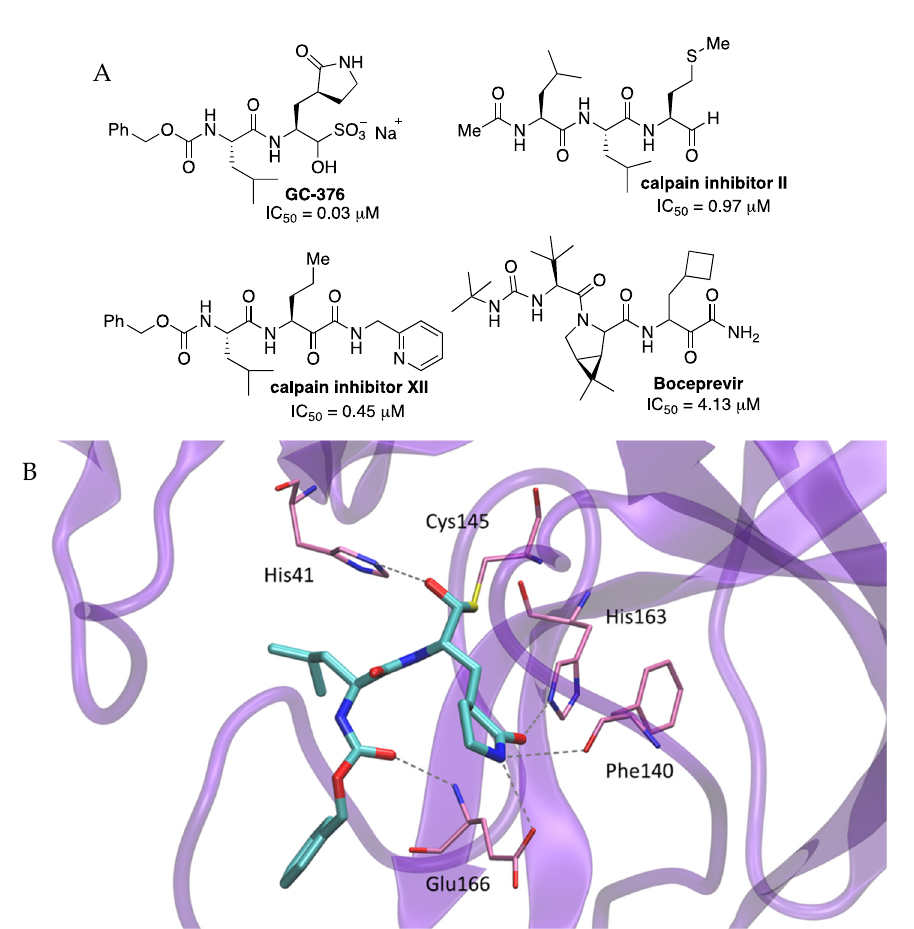
Figure 4. ( A ) Inhibitors of SARS ‐ CoV ‐ 2 Mpro enzyme. ( B ) X ‐ ray structure of the complex between GC ‐ 376 and SARS ‐ CoV ‐ 2 Mpro.